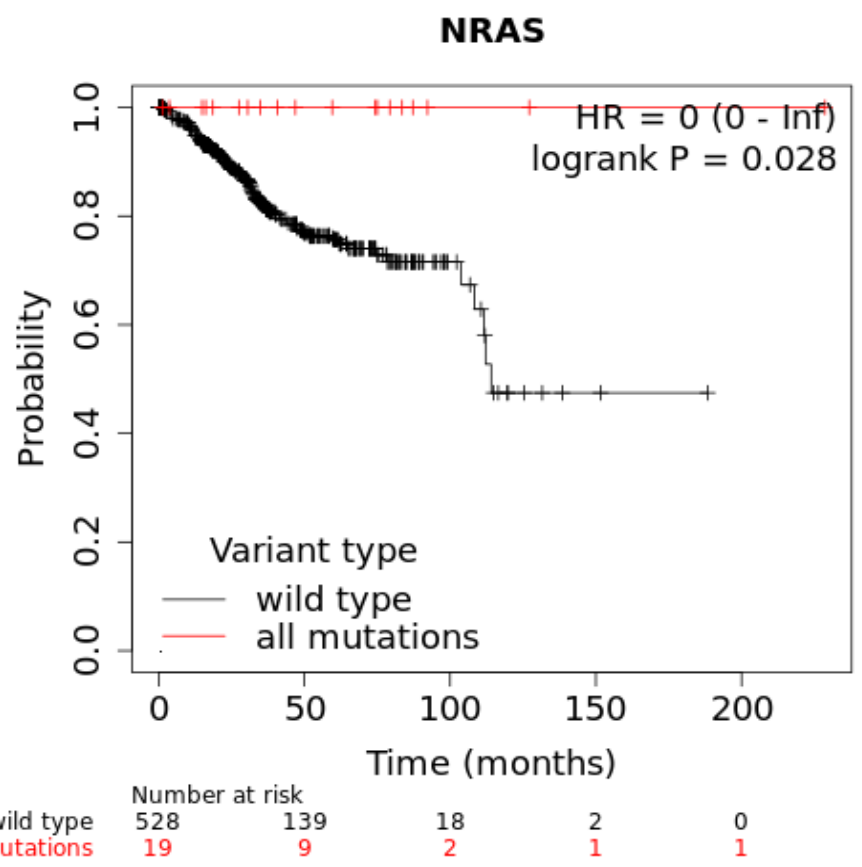
Figure 3. Kaplan–Meier plot showing the correlation between the deregulation of NRAS and overall survival rate EC.